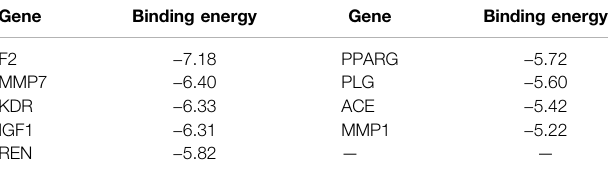
TABLE 3 | The docking information of nine targets with